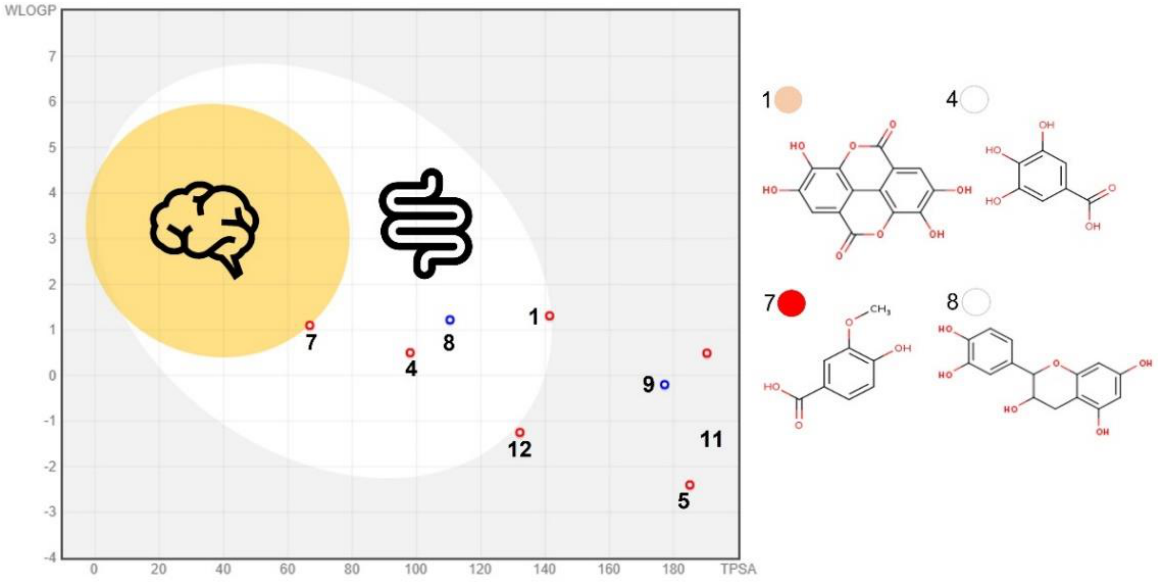
Figure 3. BOILED − Egg model for major pomegranate fruit phytochemicals. The blood − brain barrier (BBB, orange circle) and gastrointestinal (GI, white ellipse) and non-BBB/GI permeants (grey rectangle). See Figure 2 for phytochemical IDs. The model was generated in a SwissADME predictor server (http://www.swissadme.ch/index.php; accessed date: August 15 th , 2022) [23].